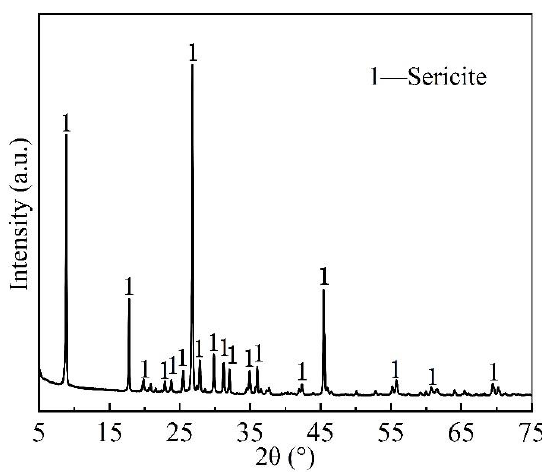
Figure 2. The XRD pattern of raw sericite. Table 1. The chemical multi-elemental analysis of sericite.